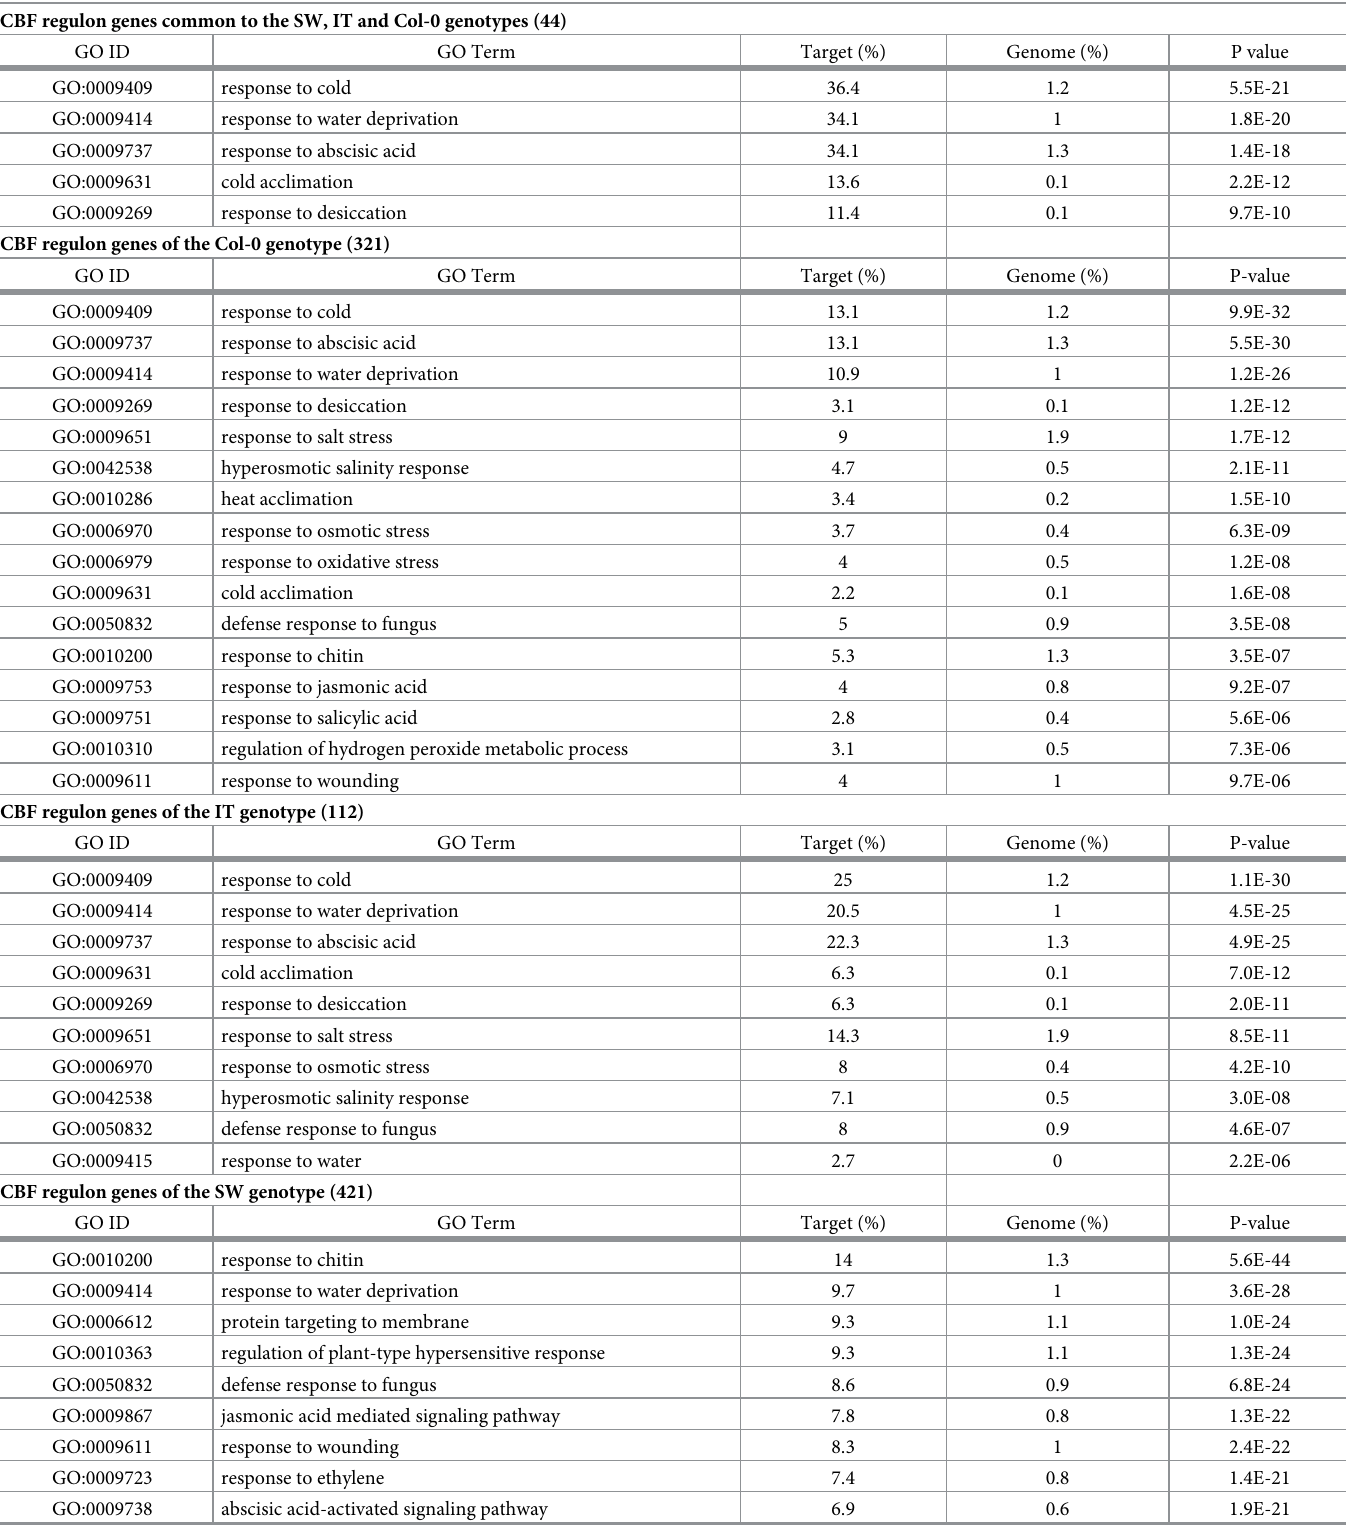
Table 3. Enrichment of GO biological processes for CBF regulon genes. CBF regulon genes common to the SW, IT and Col-0 genotypes